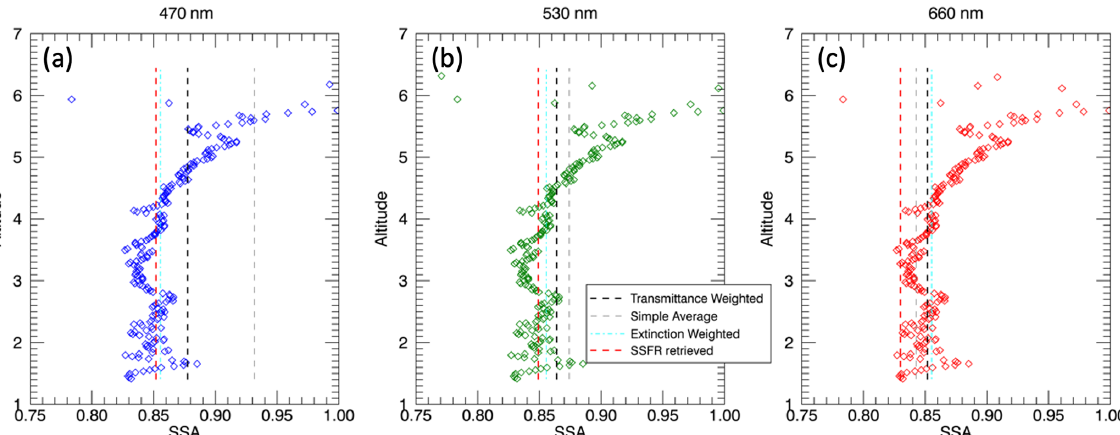
Figure C1. An example of one spiral case with the different in situ averages along with the SSFR-retrieved SSA for (a) 450nm, (b) 530nm, and (c) 660nm. The colored points show the in situ data as measured throughout the